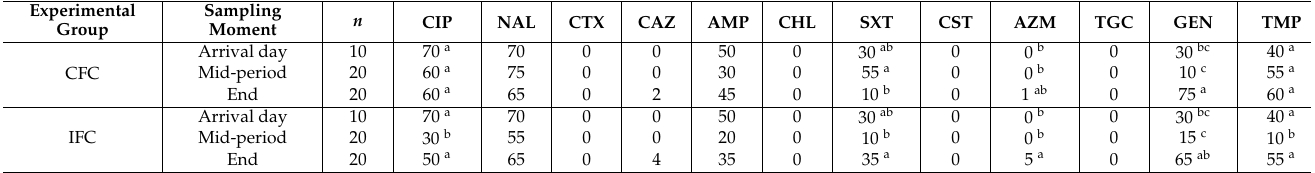
Table 3. Antimicrobial resistance rates obtained for each antibiotic in different sampling moments and experimental groups (commercial vs. improved farm conditions) throughout the growing period. Experimental